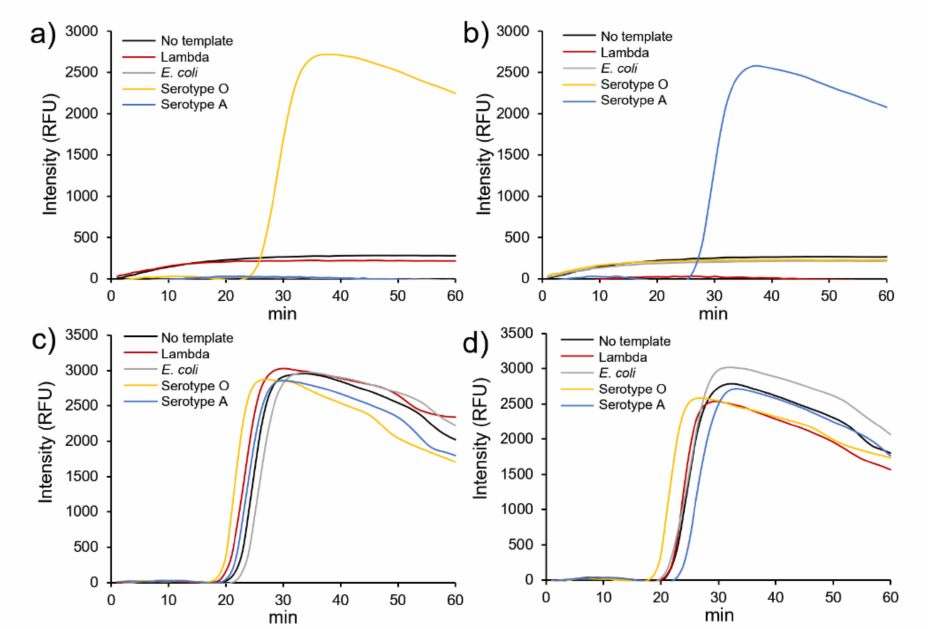
Figure 5. Specificity of loop-mediated isothermal amplification (LAMP) with GO–AuNPs (AuNPs@GO) nanocomposite using serotype O- and A-specific primers and 100 pg foot-and-mouth disease virus (FMDV) genes. ( a ) Serotype O-specific primers and ( b ) serotype A-specific primers